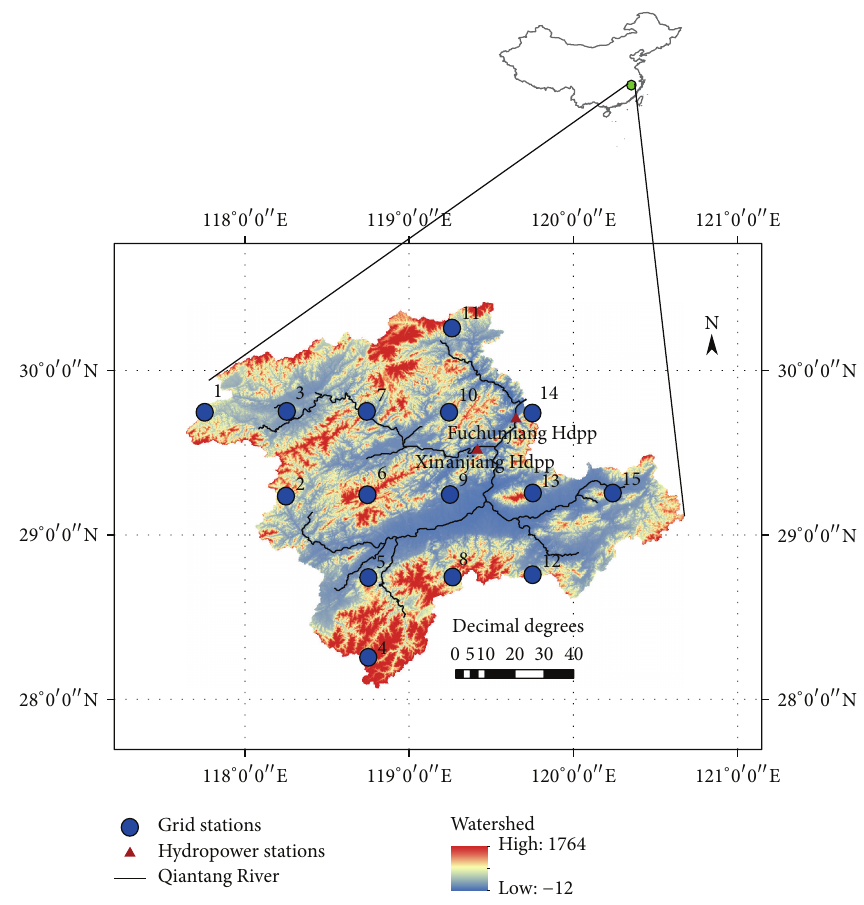
Figure 1: Spatial distribution of grid points in Xin’anjiang-Fuchunjiang watershed map.